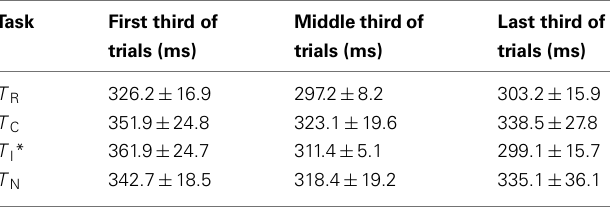
Table 2 | Reaction times during PET sessions (mean ± SEM).